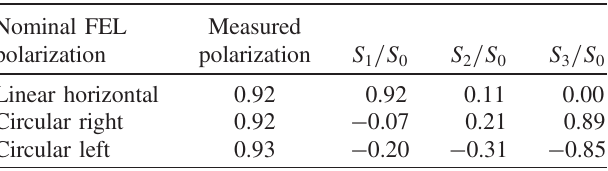
TABLE VII. Best-fit parameters for different FEL nominal polarization states (see text for the fitting procedure).